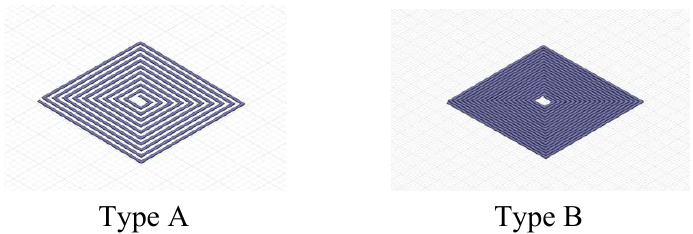
Figure 16. The coils made of printed circuit board PCB.